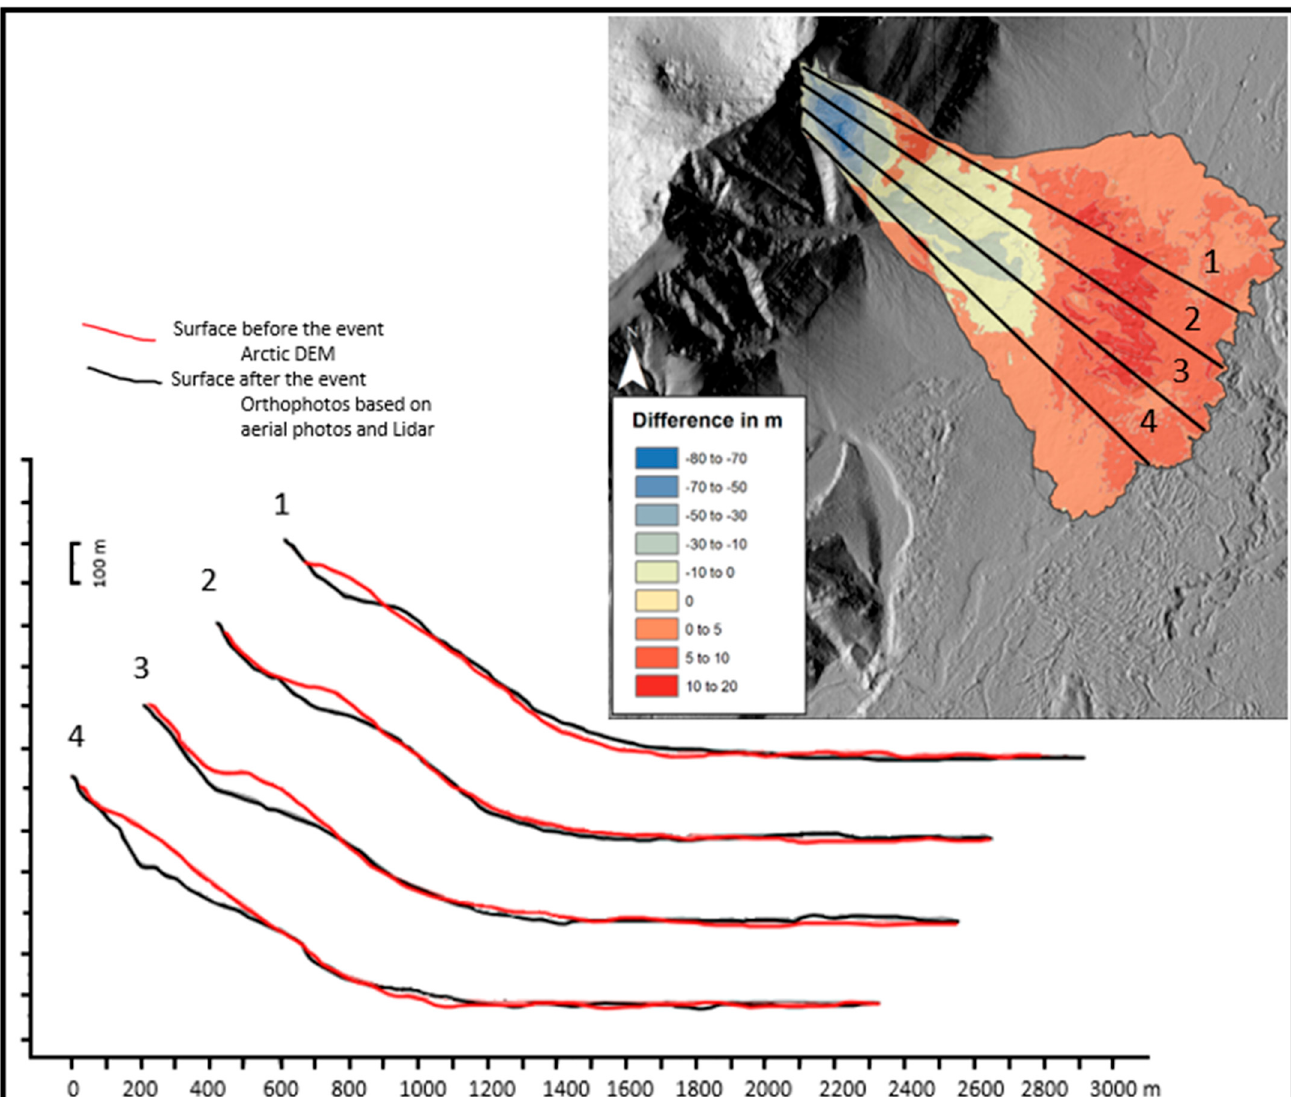
Figure 9. Longitudinal sections from DEMs of the Hítardalur landslide, modified from